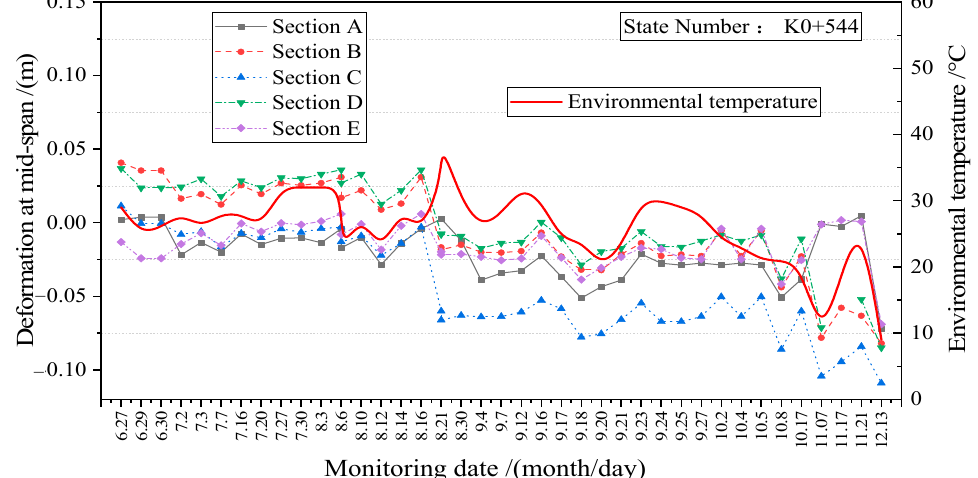
Figure 17. Deformation monitoring historical curves of the box girder at the mid-span.